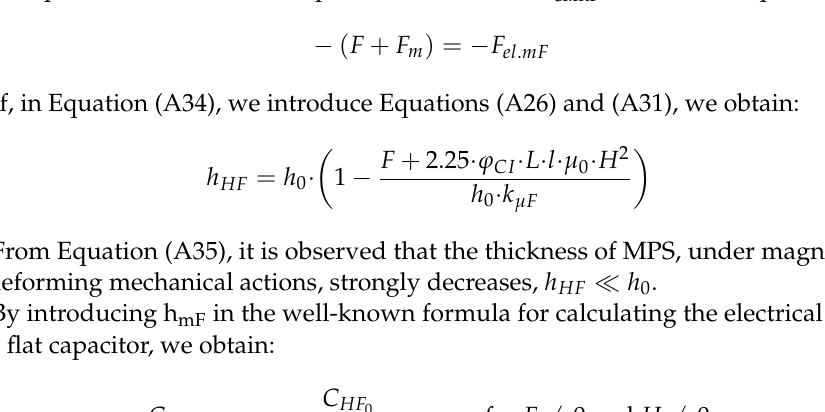
Figure A4. Cross section by MTS: ( a ) in the absence of the magnetic field and deforming forces; ( b ) after the application of the magnetic field superimposed over the field of deforming forces ( μ(cid:4652)⃗ , magnetic moment vector; Cu, copper foil; PS, polyurethane sponge; k µ F , elastic constant at the application of H and F; H, magnetic field intensity vector; Oz, coordinate axis; δ , the initial distance between the mass centers of the CI microparticles; z µ F , the distance between the magnetic dipoles at the moment t from the application of H and